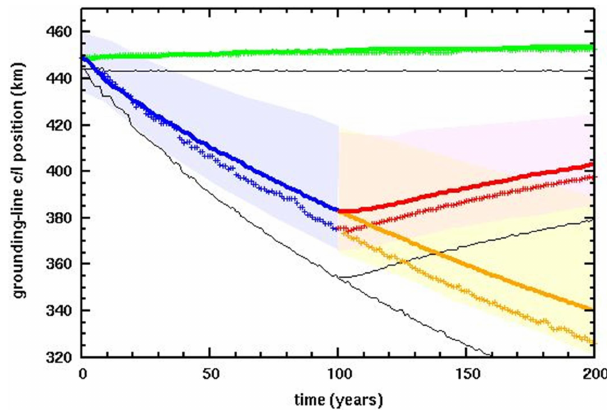
Figure 3. Along-fjord centerline position along the x axis (km) of grounding lines in the MISMIP + Ice1 experiments (Cornford et al., 2020). Thick colored lines: new model version and rheologic coefficient A = 3 × 10 − 17 Pa − 3 yr − 1 . Crosses: previous model ver- sion and A = 2 . 5 × 10 − 17 Pa − 3 yr − 1 . Thin black lines: previous model version and A = 3 . 5 × 10 − 17 Pa − 3 yr − 1 . Green: control, with zero oceanic melt. Blue and yellow: with oceanic melt perturbation. Red: with oceanic melt reset to zero after year 100. Shaded regions show the envelopes for the “main subset” of MISMIP + models, copied from Cornford et al. (2020, their Fig.